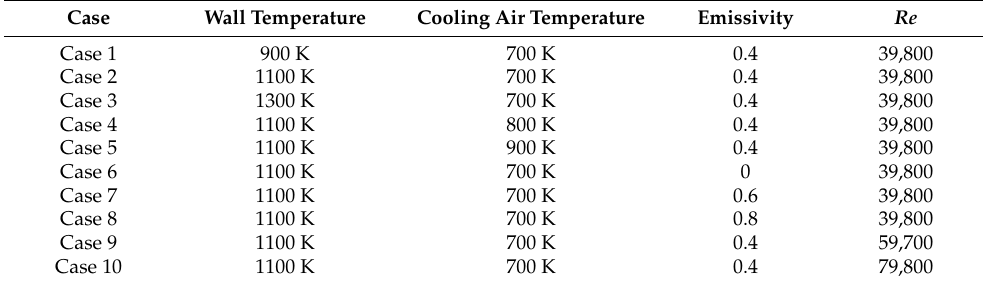
Table 4. Simulation examples.